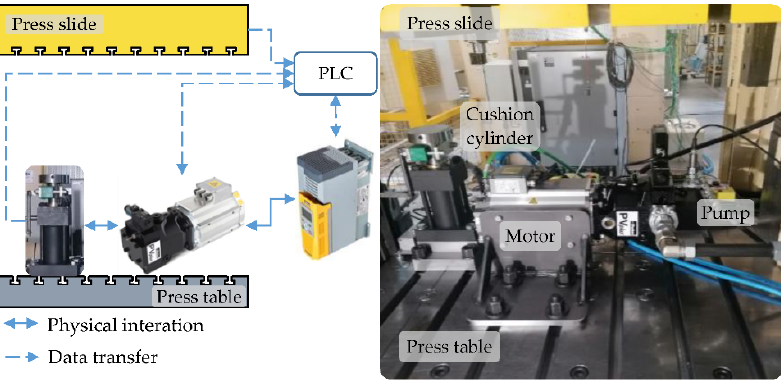
Figure 2. Hardware platform Parker drive-controlled pump.